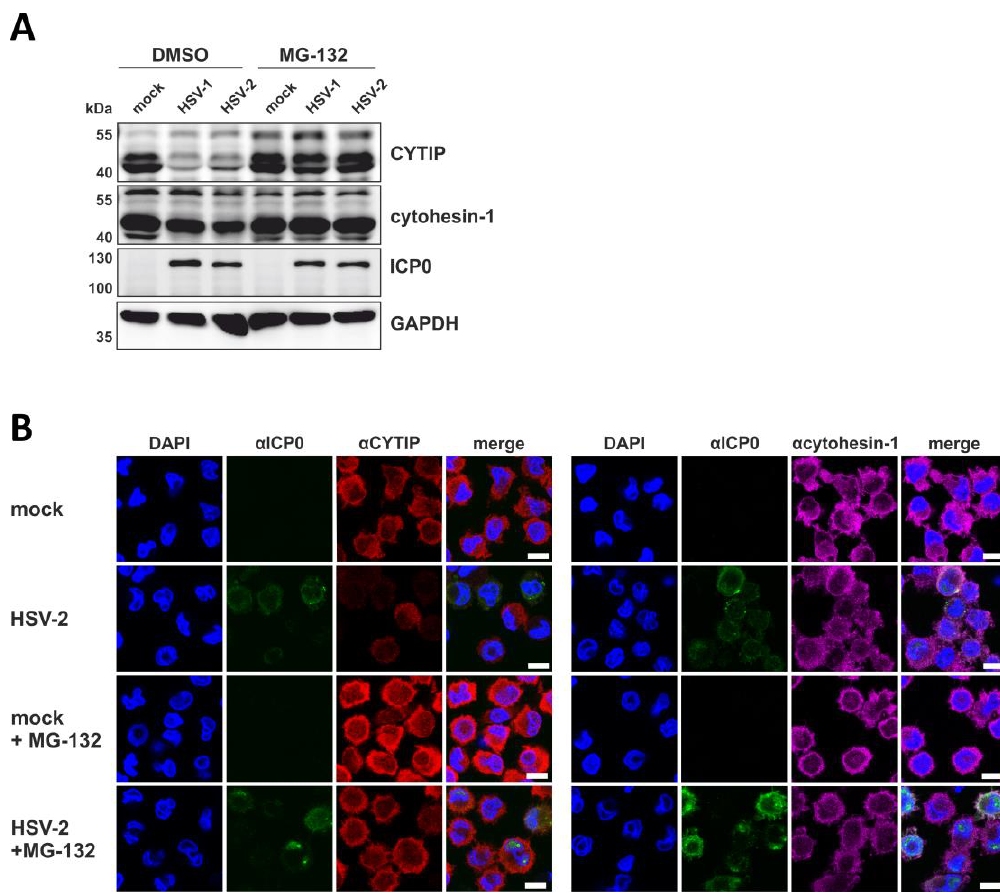
Figure 10. HSV-2 induces proteasomal degradation of CYTIP in mDCs. Mock-, HSV-1- (MOI of 1), or HSV-2- (MOI of 5) infected mDCs were treated with or without the proteasomal inhibitor MG-132 (10 µM) and harvested 16 hpi. As a control, cells were treated with DMSO. (A) Protein lysates were subjected to Western blot analysis using equal protein amounts loaded on a 12% acrylamide SDS-gel. Expression levels of CYTIP, cytohesin-1, ICP0 as infection control, or GAPDH as loading control, were monitored using specific antibodies. (B) Immunofluorescence staining using an αCYTIP (left panel) or αcytohesin-1 (right panel) primary antibody followed by staining with an AlexaFluor555-tagged secondary antibody was performed. Infection was visualized by using a primary antibody specific for HSV ICP0 followed by staining with an AlexaFluor488-coupled secondary antibody. The nucleus was stained using Dapi. The scale bar indicates 10 µm. The experiments were performed three times with cells from different healthy donors and representative data are shown.